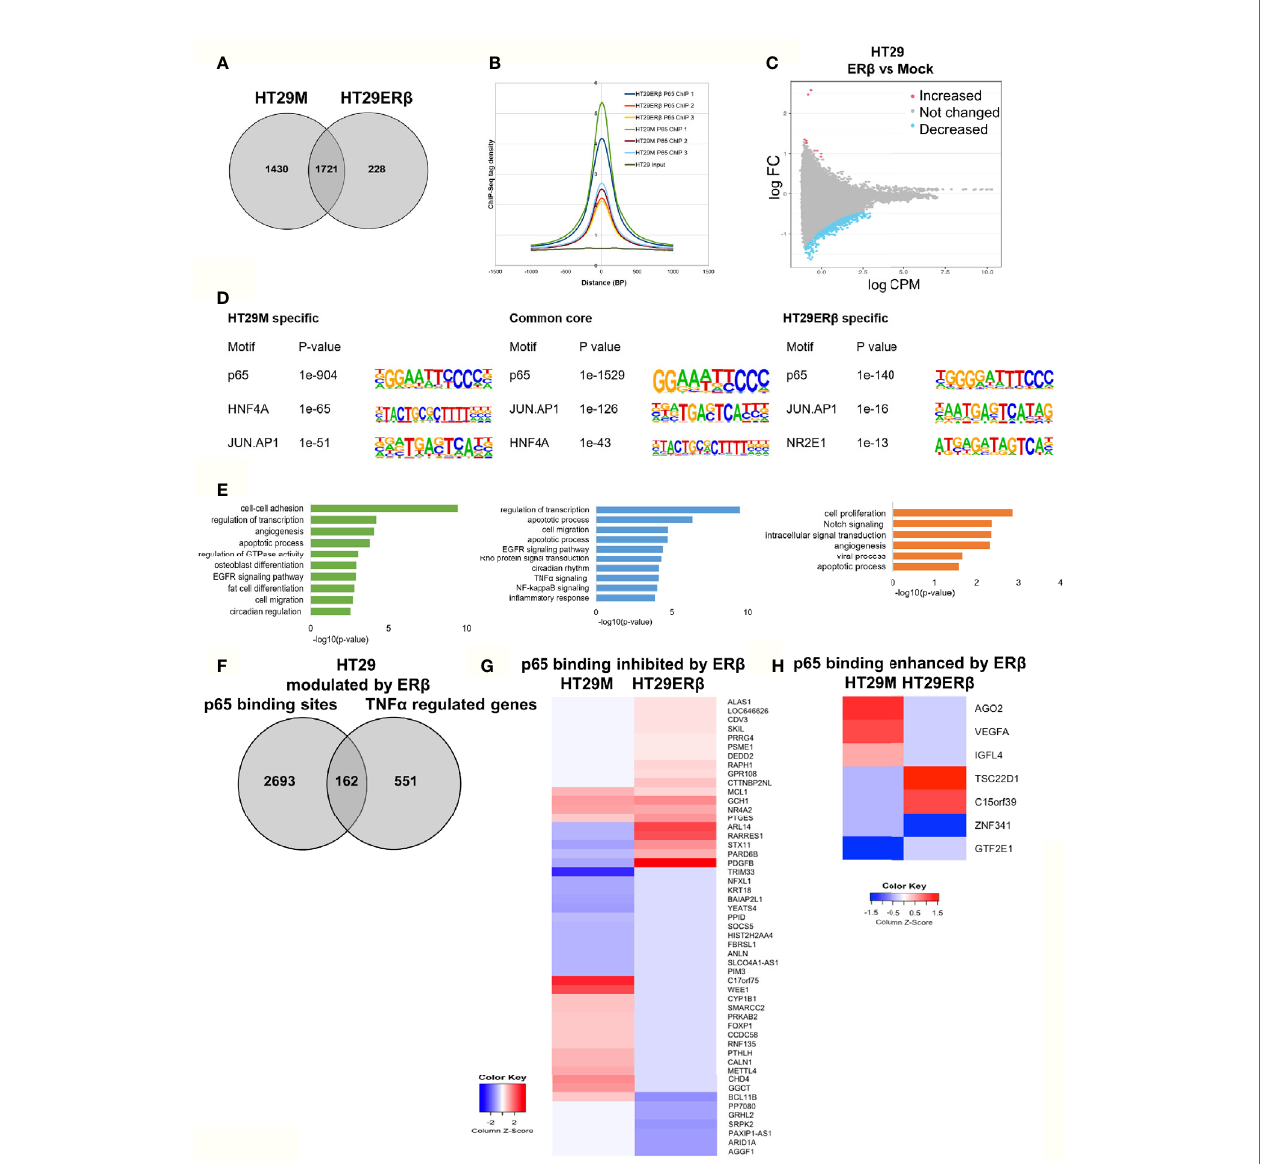
FIGURE 5 | ER b diminishes p65 chromatin binding in HT29 cells. (A) Venn diagram comparing p65 binding sites in HT29 cells with and without expression of ER b . (B) Density plot representing the distribution of p65 tag densities in three replicates each of HT29 cells with and without ER b . (C) Volcano plot highlighting statistically signi fi cant differences of p65 binding in HT29 cells in presence and absence of ER b , using sliding window approach. (D) Motifs highly enriched in p65-bound sequencing in HT29 cells only in absence of ER b , regardless of ER b expression (core genes), and only in presence of ER b , respectively. HOMER was used to identify genomic distribution and motifs of p65 binding sites across the genome. (E) Biological functions enriched among genes located nearest to p65 binding sites in HT29 cells depending on ER b expression. (F) Overlap of genes located nearest to the p65 binding sites and those genes where ER b expression impacted TNF a gene response in HT29 cells. (G, H) Heatmap representing ER b modulation of the TNF a -regulated genes, of genes located nearest to p65 binding that was (G) inhibited and (H) enhanced by ER b in HT29 cells. Z score values were calculated from the logarithmic fold changes, which represent a value ’ s relationship to the mean of a group of values. A positive Z score indicates the values above the mean and negative if it is below the